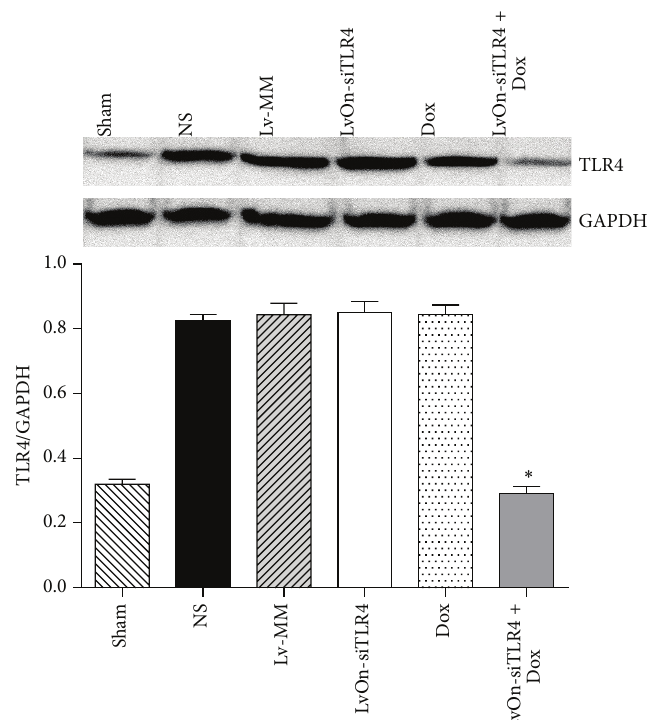
Figure 3: Western blot assay of TLR4 expression. On the 7th day after viral injection, the protein of lumbar spinal cord was prepared and the expression of TLR4 was detected. The protein expression of TLR4 in the Lv-siTLR4 with Dox group was also markedly downregulated compared to the other four groups receiving Walker 256 cells injection ( ∗ 𝑃 < 0.01 versus Lv-siTLR4 group, Lv-MM group, NS group, and Dox group, one-way ANOVA analysis, 𝑁 = 6